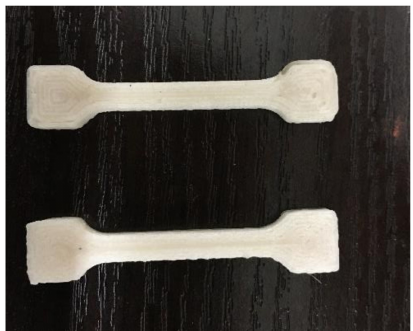
Figure 1. Printed specimens of ABS / octyl-QDED for tensile